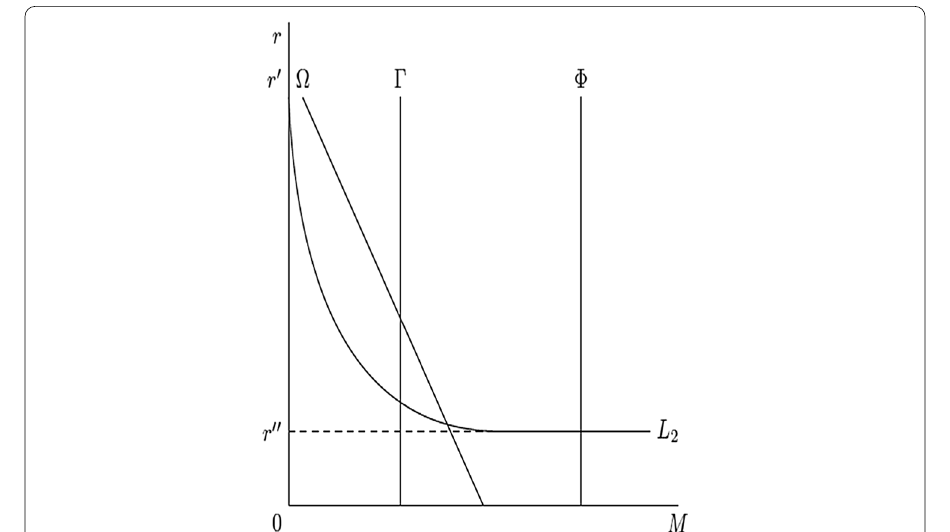
Fig. 5 The money demand M by lenders on the y axis. Interest rates on the y axis are labeled as r I and r II . The challenger banks are represented by the line labeled Γ. They have a price and technology advantage and so can lend at higher interest rates. The brokers are represented by the line labeled Ω. They are price takers, accepting the interest rate determined by the market. The same is true for the incumbents, represented by the line labeled Φ but they have a greater market share due to their customer relationships. Note that payments strategy for social media platforms is not shown on this figure as it is not affected by interest